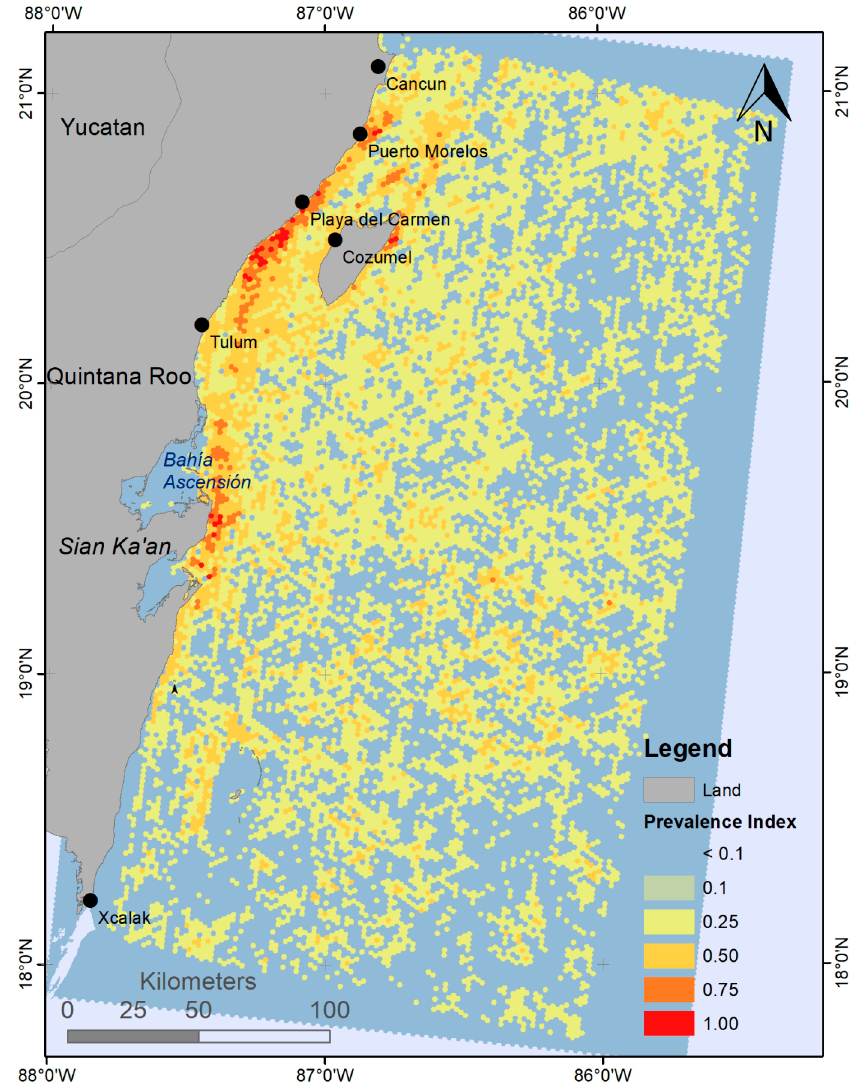
Figure 8. Prevalence index of sargasso in the Mexican Caribbean, January 2016–August 2020, detected with Landsat 8 imagery.